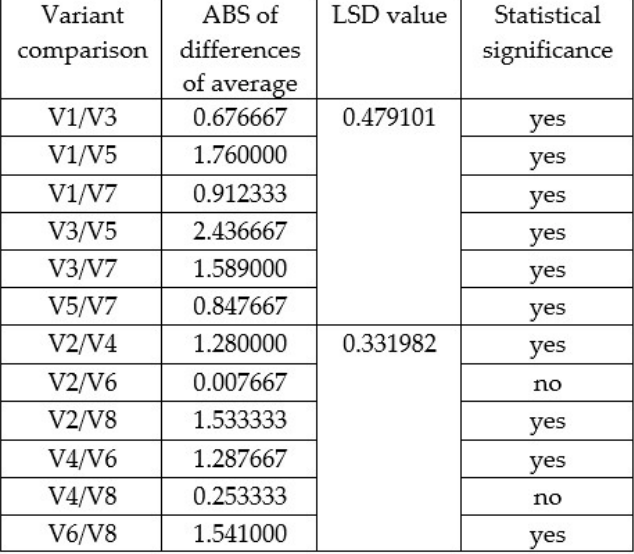
Figure 8. The statistical significance determined by LSD (Least Significant Difference) test values of Lepidium sativum L. sprout radicles’ length on gauze (V1 control, illuminated with sunlight; V3, illuminated with white LED; V5, illuminated with blue LED; and V7, illuminated with red LED experimental variant) or biochar (V2 control, illuminated with sunlight; V4, illuminated with white LED; V6, illuminated with blue LED; and V8, illuminated with red LED experimental variant,) t crit value = 1.980626.